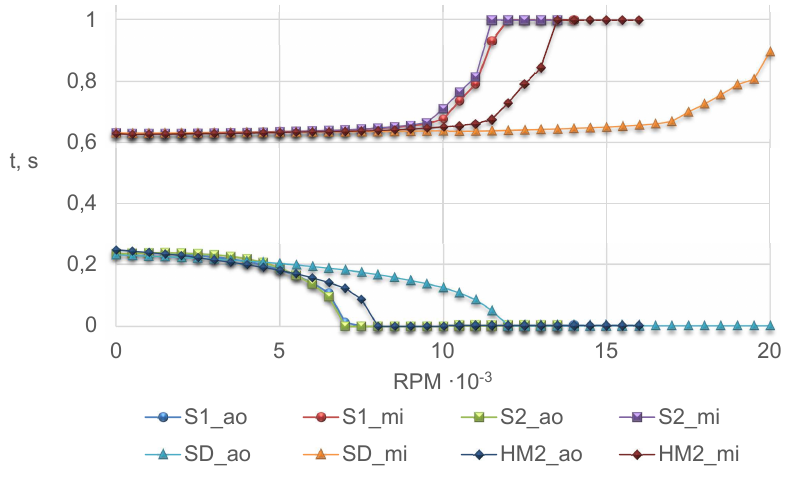
Figure 3. Duration of the opening of the aortic and mitral valves. S1—Sputnik 1, S2—Sputnik 2, SD — Sputnik D, HM2 — HeartMate II. The lower index ao stands for aortic valve, mi stands for mitral